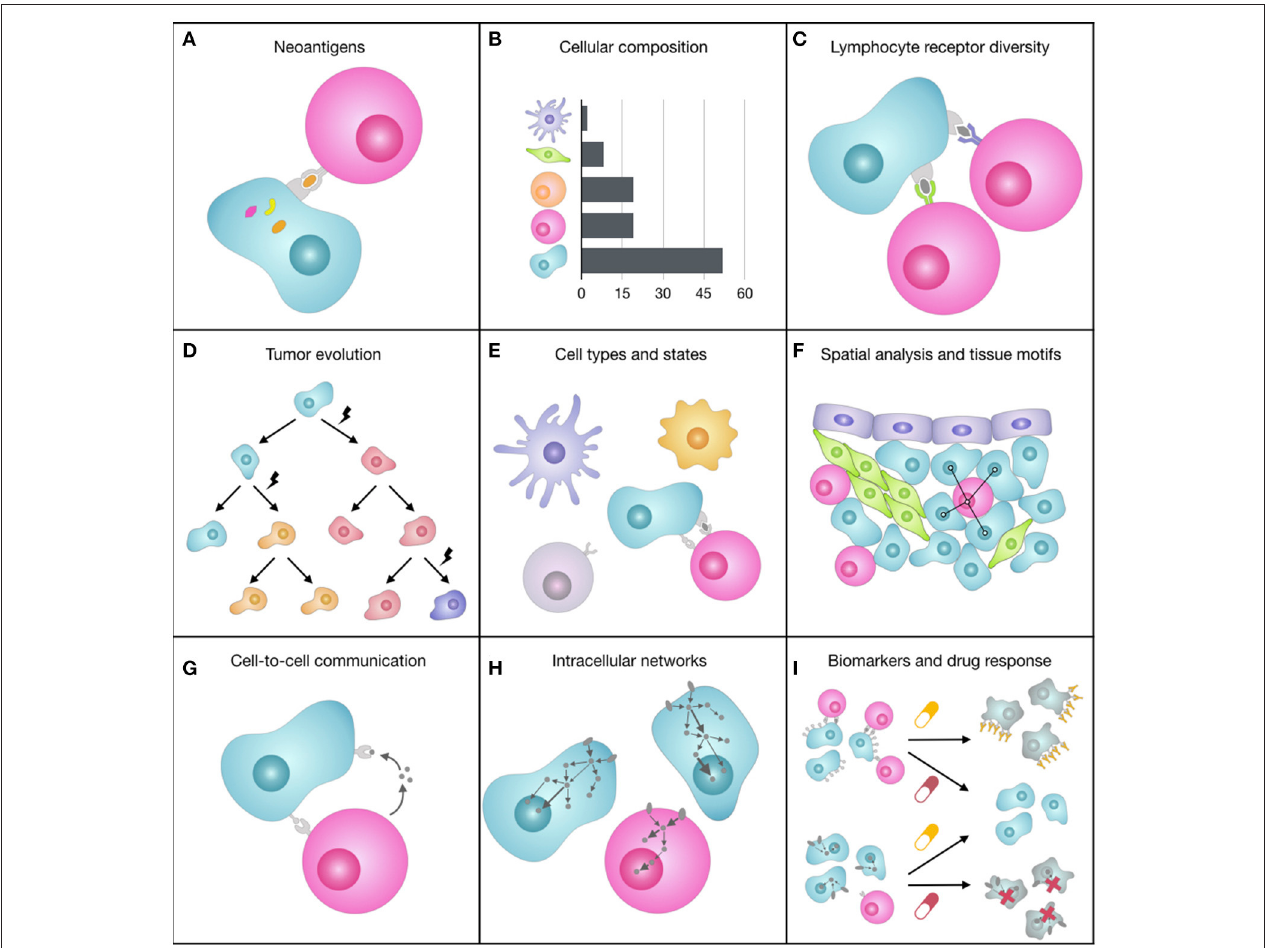
FIGURE 2 | Representation of some of the facets of the tumor microenvironment (TME). (A) The expression of mutated genes can generate tumor-specific neoantigens, i.e., peptides bound to the tumor cell HLAs that can be recognized by T cells and elicit an immune response. (B) The quantification of the different cell types of the TME, which can have pro- or anti-tumorigenic roles, can provide prognostic, and predictive markers for immunotherapy. (C) The immense diversity of lymphocyte receptors, which can be different from lymphocyte to lymphocyte, allows the immune system coping with a wealth of unpredictable antigens and varies greatly depending on spontaneous or therapy-induced anticancer immune responses. (D) During tumor progression, cancer cells accumulate somatic mutations that increase intra-tumoral heterogeneity and can change cell fitness and response to drugs. (E) The TME is composed of various cell subtypes (e.g., CD4 + and CD8 + T cell), which are in turn characterized by different functional orientations (e.g., naïve, effector, memory CD8 + T cell) and states (e.g., activated, anergic, exhausted CD8 + T cell). (F) The spatial organization of cells, such as cell neighbors (e.g., proximity of tumor and immune cells) or cellular patterns (i.e., tissue motifs, such as stem-cell niches), reflects biological processes at the tissue level. (G) Cells constantly exchange signals with surrounding cells by secreting molecules (e.g., cytokines, chemokines, growth factors) or by direct ligand-receptor binding on the cell surfaces (e.g., immune checkpoints). (H) When ligands bind to cell receptors, the cell responds by processing this signal through a complex signal transduction network that transmits information to the nucleus, where transcription factors regulate the transcriptional response of the cell. (I) Most of cancer therapies, such as immunotherapy with immune checkpoint blockers or targeted therapy, act on molecules responsible for inter- and intra-cellular communication that are deregulated in cancer, trying to restore the normal behavior of the cells.